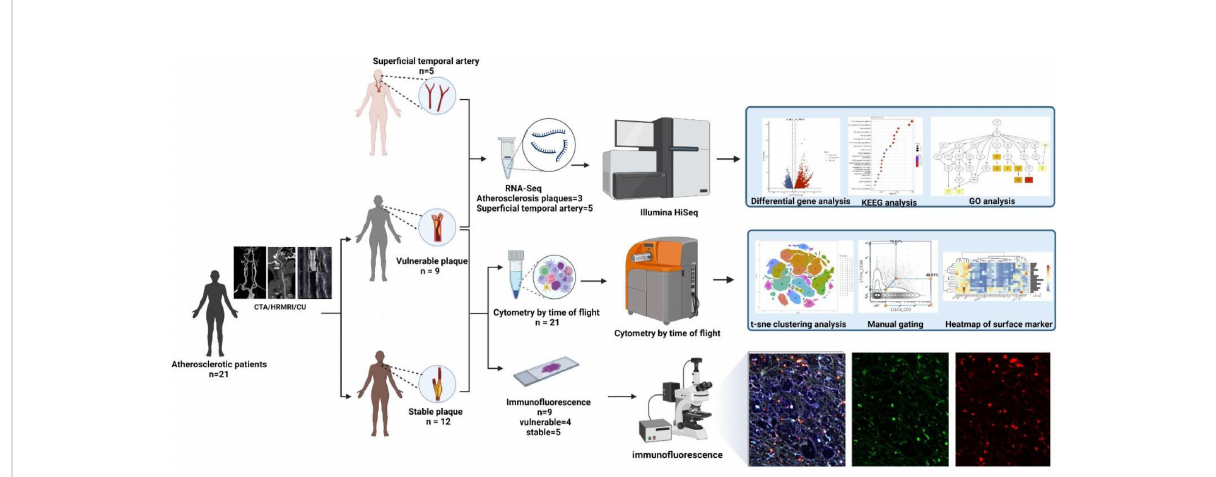
FIGURE 2 Work fl ow: According to preoperative imaging data, 21 enrolled atherosclerotic patients were divided into the vulnerable plaque group (n=9) and the stable plaque group (n=12). All plaques were examined by Mass Cytometry after special treatment. Among them, 9 remaining plaque samples were paraf fi n-embedded and were stained with immuno fl uorescent antibodies. Atherosclerotic plaques from 3 additional patients were performed for RNA-seq analysis. In addition, super fi cial temporal artery from 5 patients undergoing craniocerebral trauma surgery were also used for RNA-seq analysis as control groups (This Figure was created by